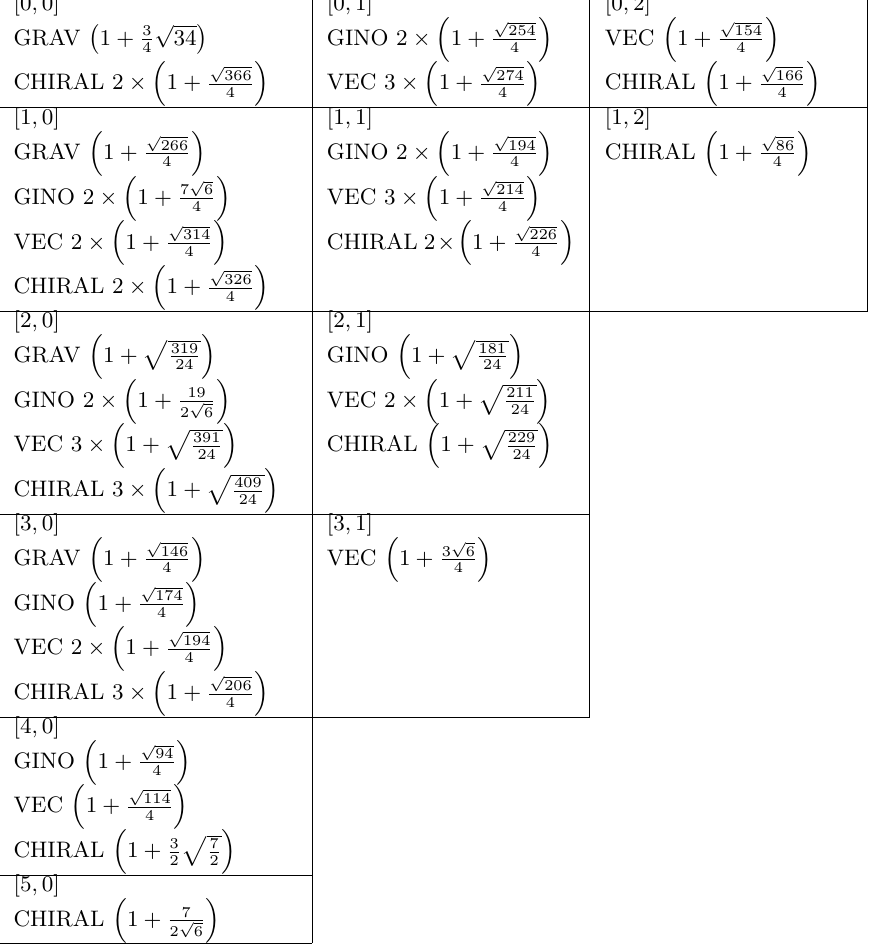
Table 5 . Supermultiplets at KK level n = 3 for the D = 11 N = 1 G 2 -invariant AdS 4